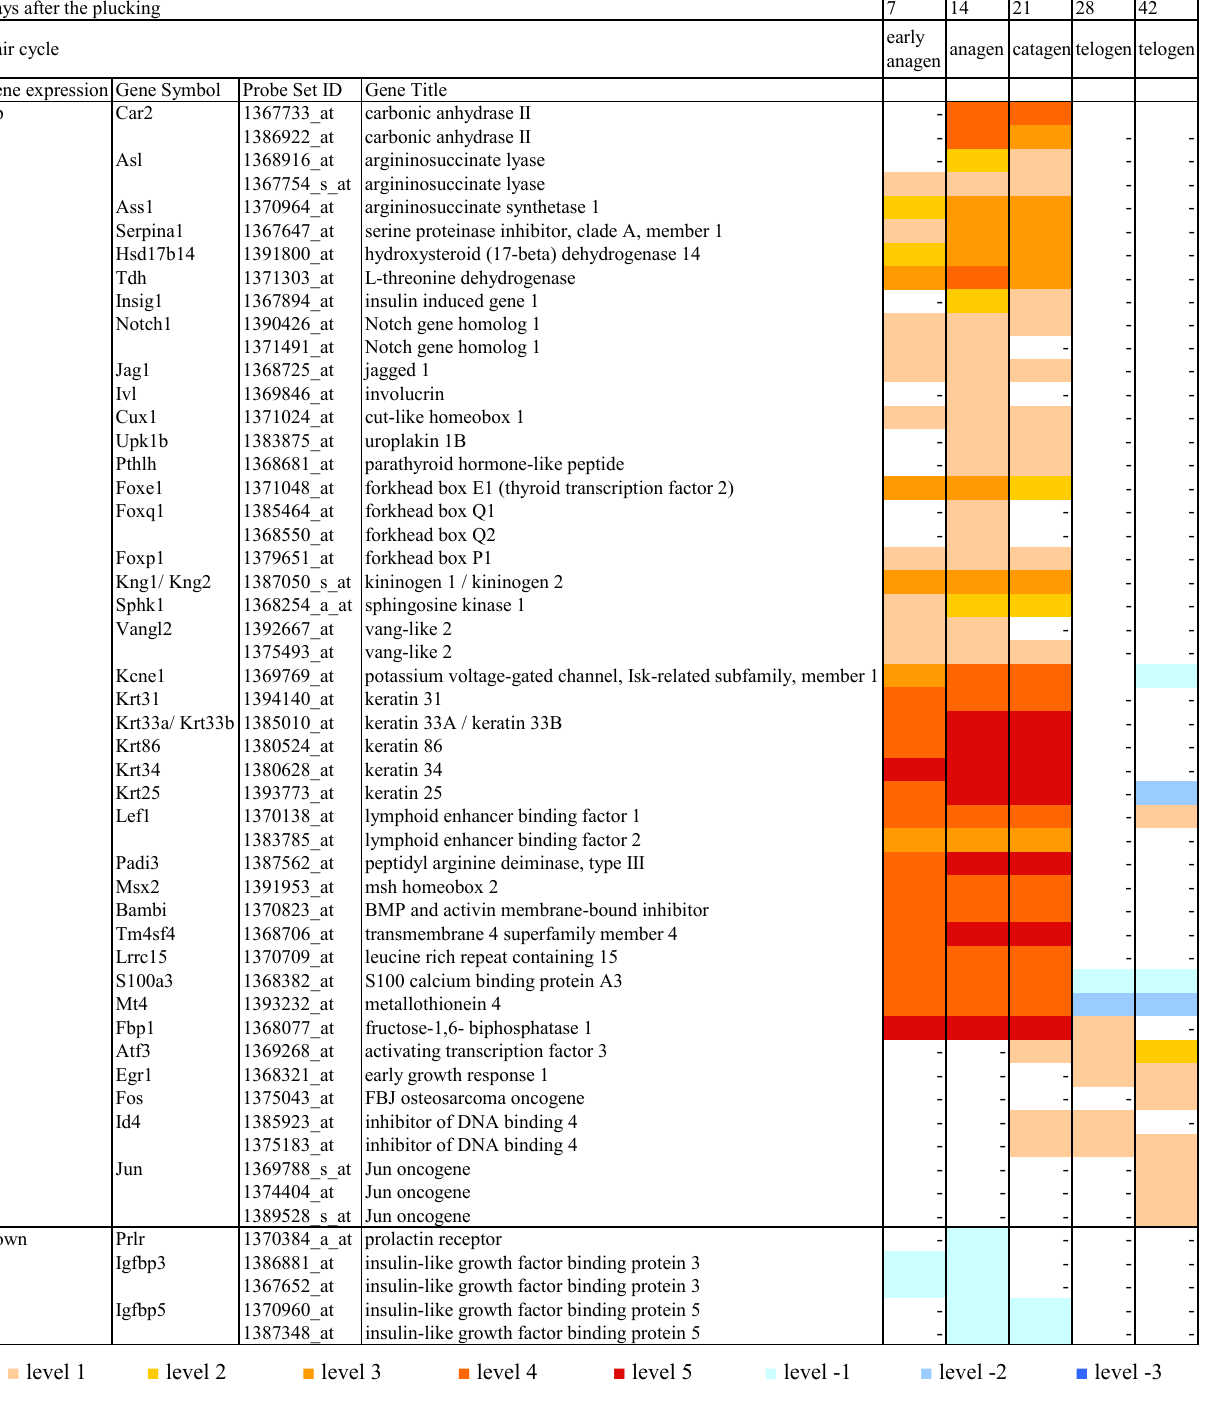
Figure 5. Expression pattern of main genes in dorsal skin of male Mini rats after depilation of telogen-phase hairs at 10 weeks